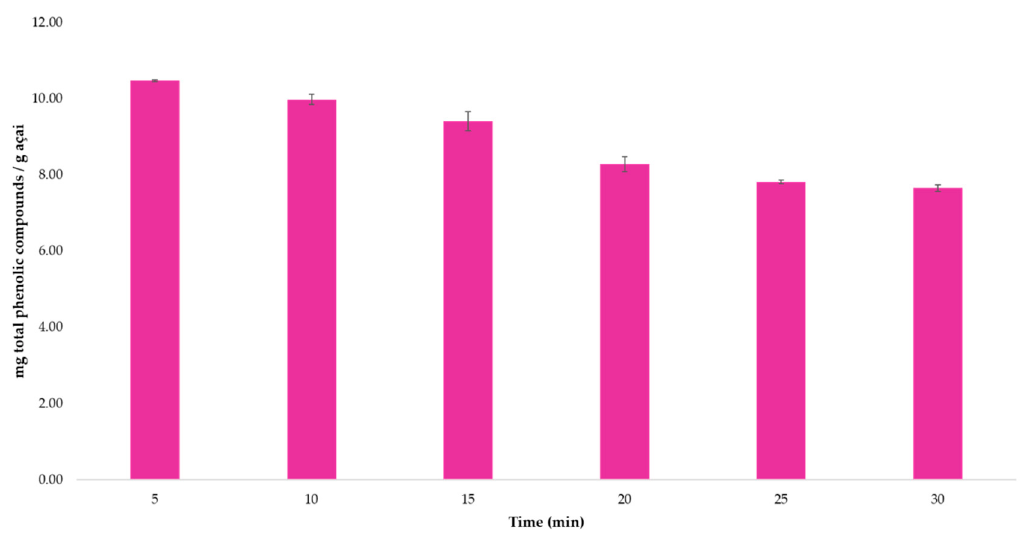
Figure 4. Mg of TPC / g açai recovered during the kinetic study ( n = Figure 4. Mg of TPC/g açai recovered during the kinetic study ( n = 3).